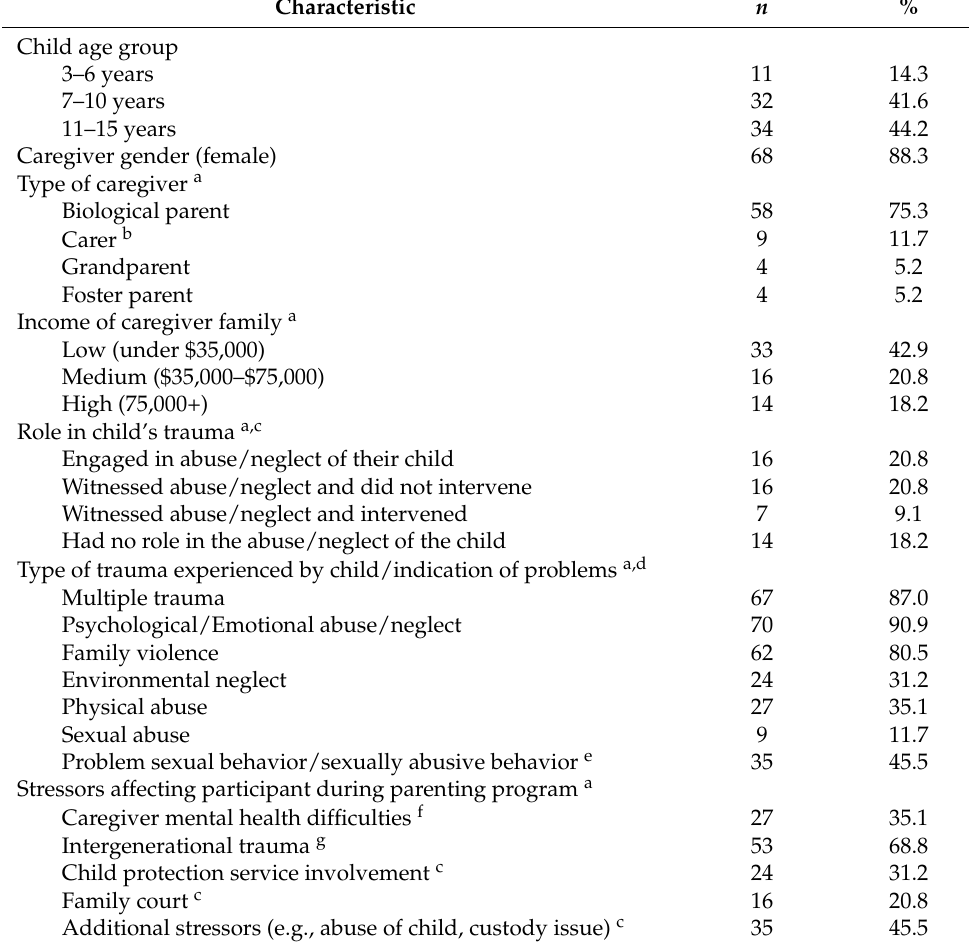
Table 1. Participant descriptives (N =